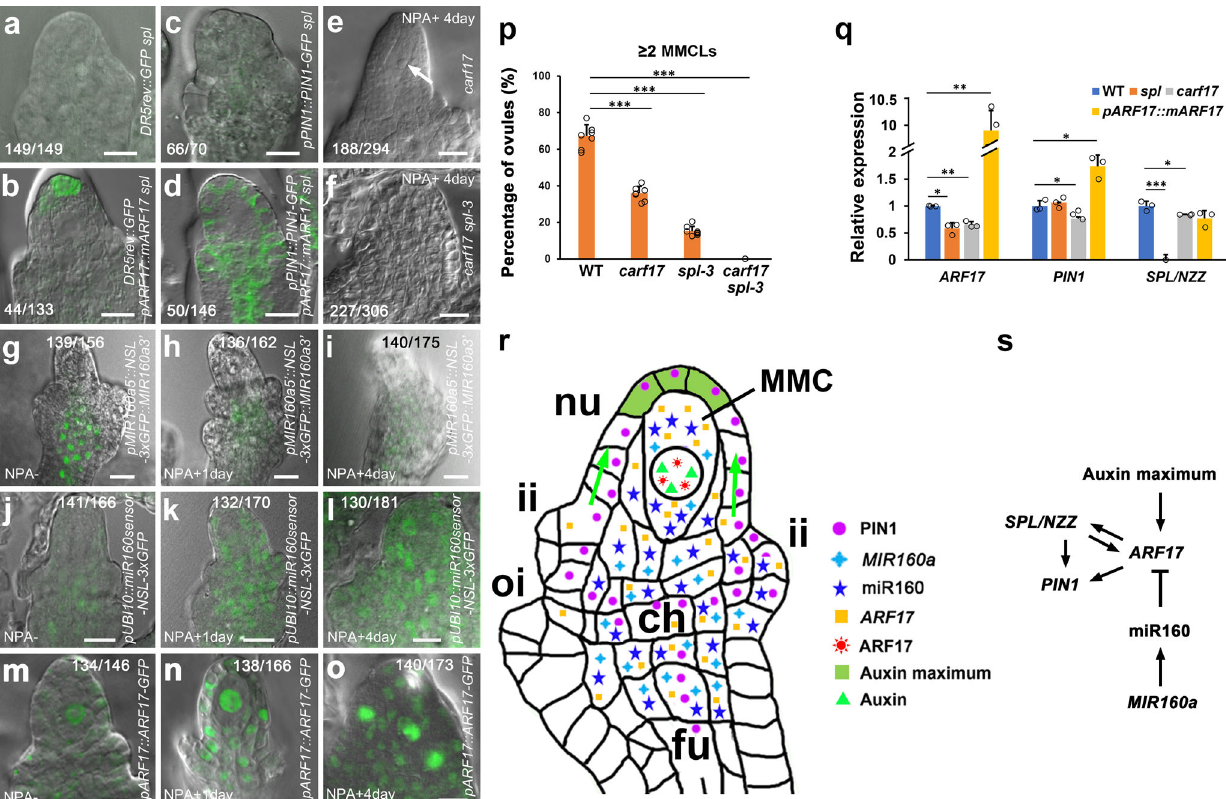
Fig. 7 | Auxin signaling controls MMC speci fi cation through ARF17 and SPL / NZZ . a – d Merged confocal and DIC images of ovules showing rescued auxin signaling by overexpression of ARF17 . a Absence of auxin maximum in the DR5rev::GFPspl ovule. b Therestoredauxinmaximumtotheapexofnucellusinthe DR5rev::GFP pARF17::mARF17 spl ovule. c Almost no detectable PIN1 in the pPIN1::- PIN1-GFP spl ovule. d Partially rescuedPIN1 expression atthe epidermisof nucellus and chalaza in the pPIN1::PIN1-GFP pARF17::mARF17 spl ovule. e , f DIC images of ovulesshowingoneMMC(arrow)inthe carf17 ovule,butnoMMCinthe carf17spl-3 ovule after NPA treatment. g – i NPA treatment represses the MIR160a ( FOC ) expression.MergedconfocalandDICimagesof pMIR160a5 ’ ::NSL-3xGFP::MIR160a3 ’ expression in MMCLs. Merged confocal and DIC images of pARF17::ARF17-GFP ovulesshowingelevatedlevelsofARF17proteininMMCLsandothersubepidermal